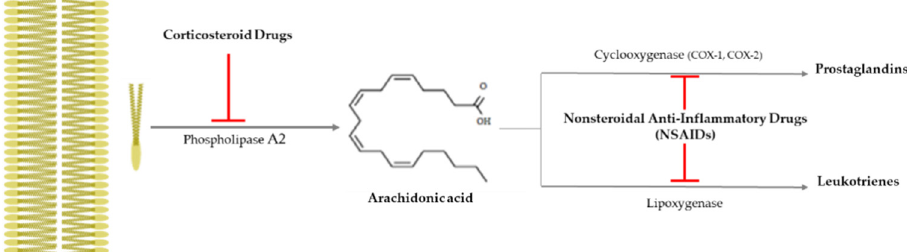
Figure 3. Anti-inflammatory pathway caused by corticosteroid drugs and nonsteroidal anti-inflammatory drugs (NSAIDs). Corticosteroid drugs inhibit the formation of arachidonic acid by causing plasma membrane breakage, which is caused by phospholipase A 2 . On the other hand, nonsteroidal anti-inflammatory drugs (NSAIDs) only control arachidonic acid and prostaglandins through cyclooxygenase 1 or 2 (COX-1 or -2). Table 4. Summary of anti-inflammatory drugs for AMD treatment.